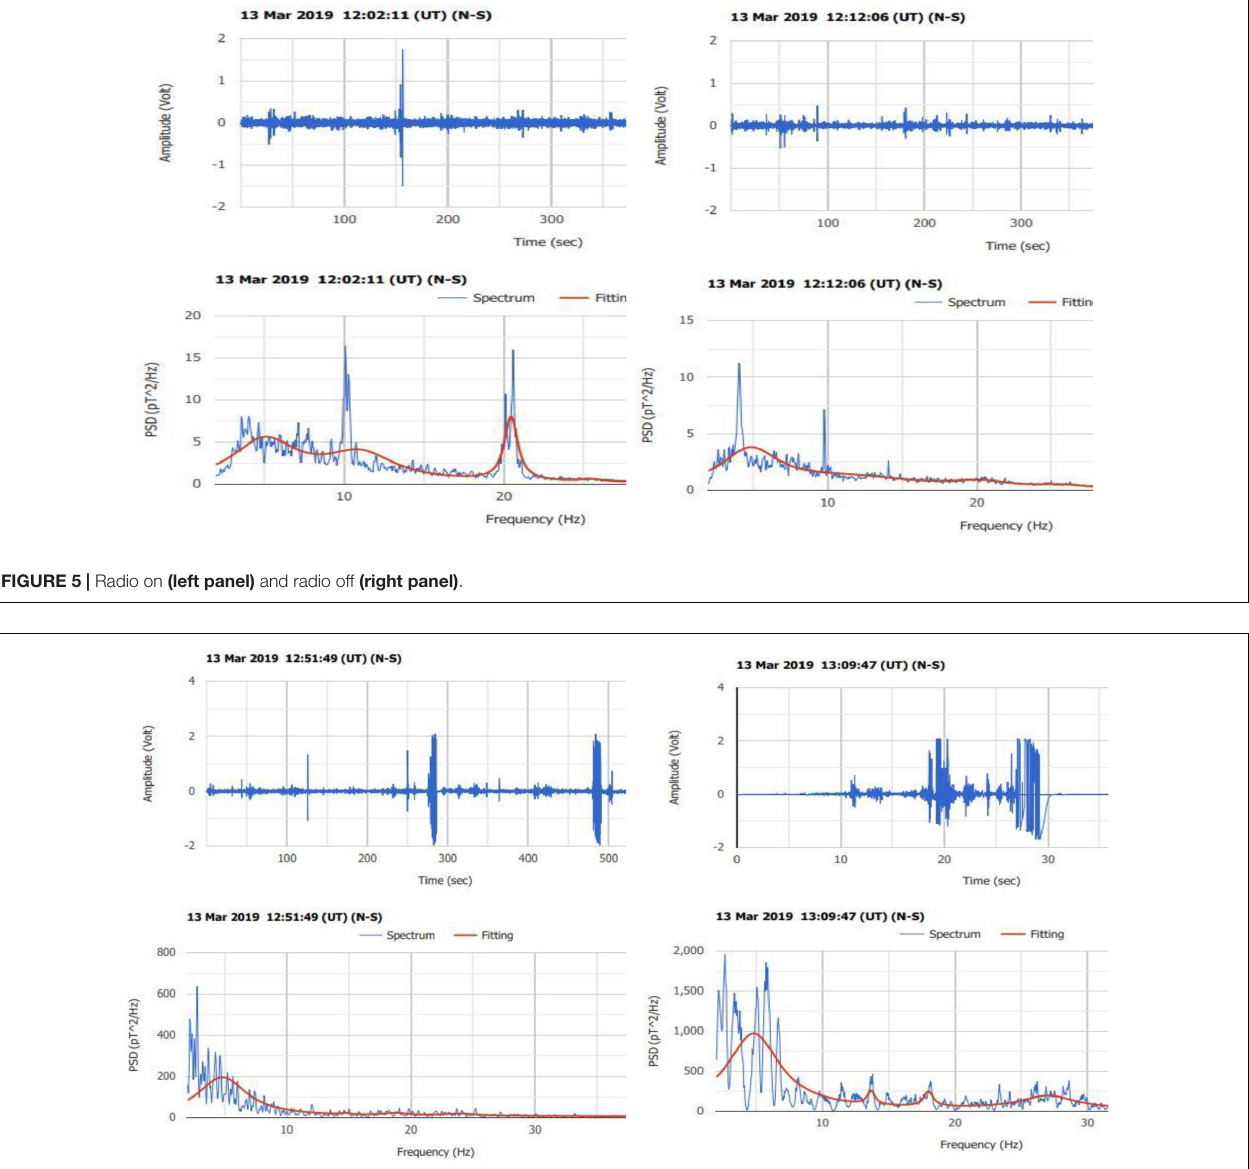
Frontiers in Earth Science |